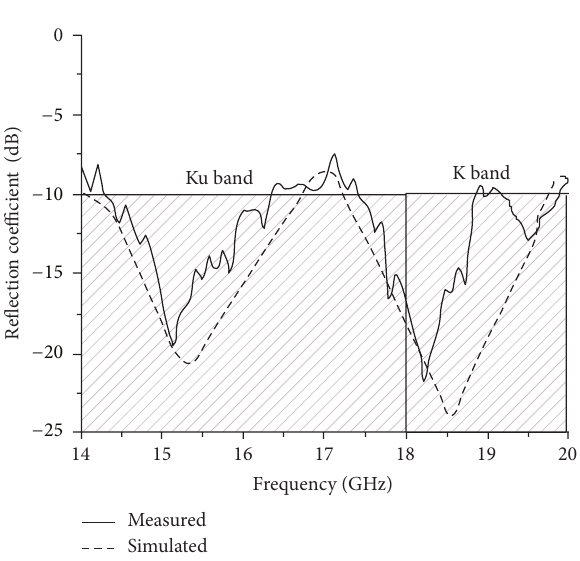
Figure 5: Simulated and measured gains of the proposed antenna.